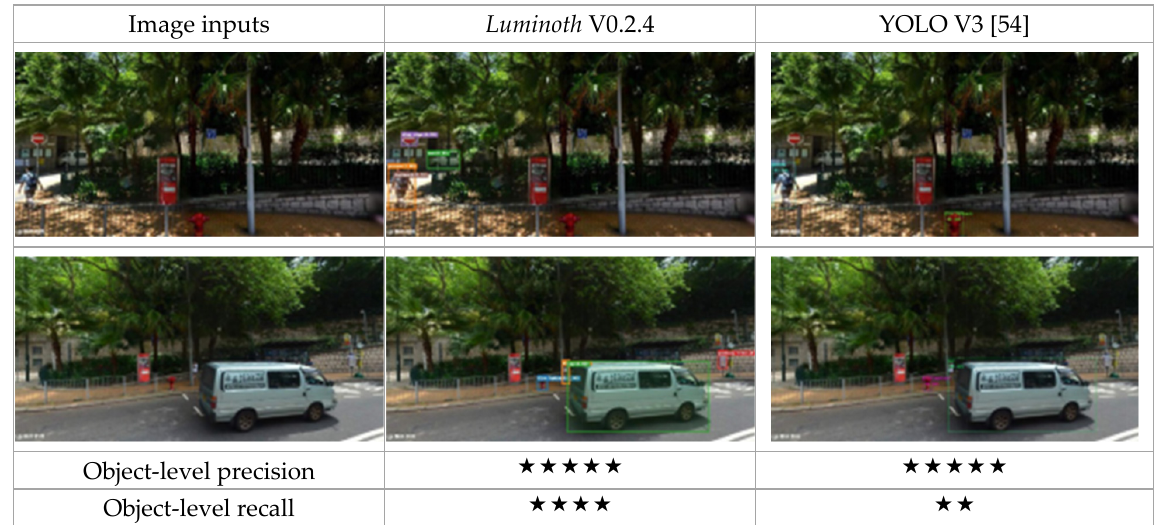
Figure 2. Illustrations of object detection by transferring two trained R-CNN models, where the boxes indicate urban objects defined in COCO [55]